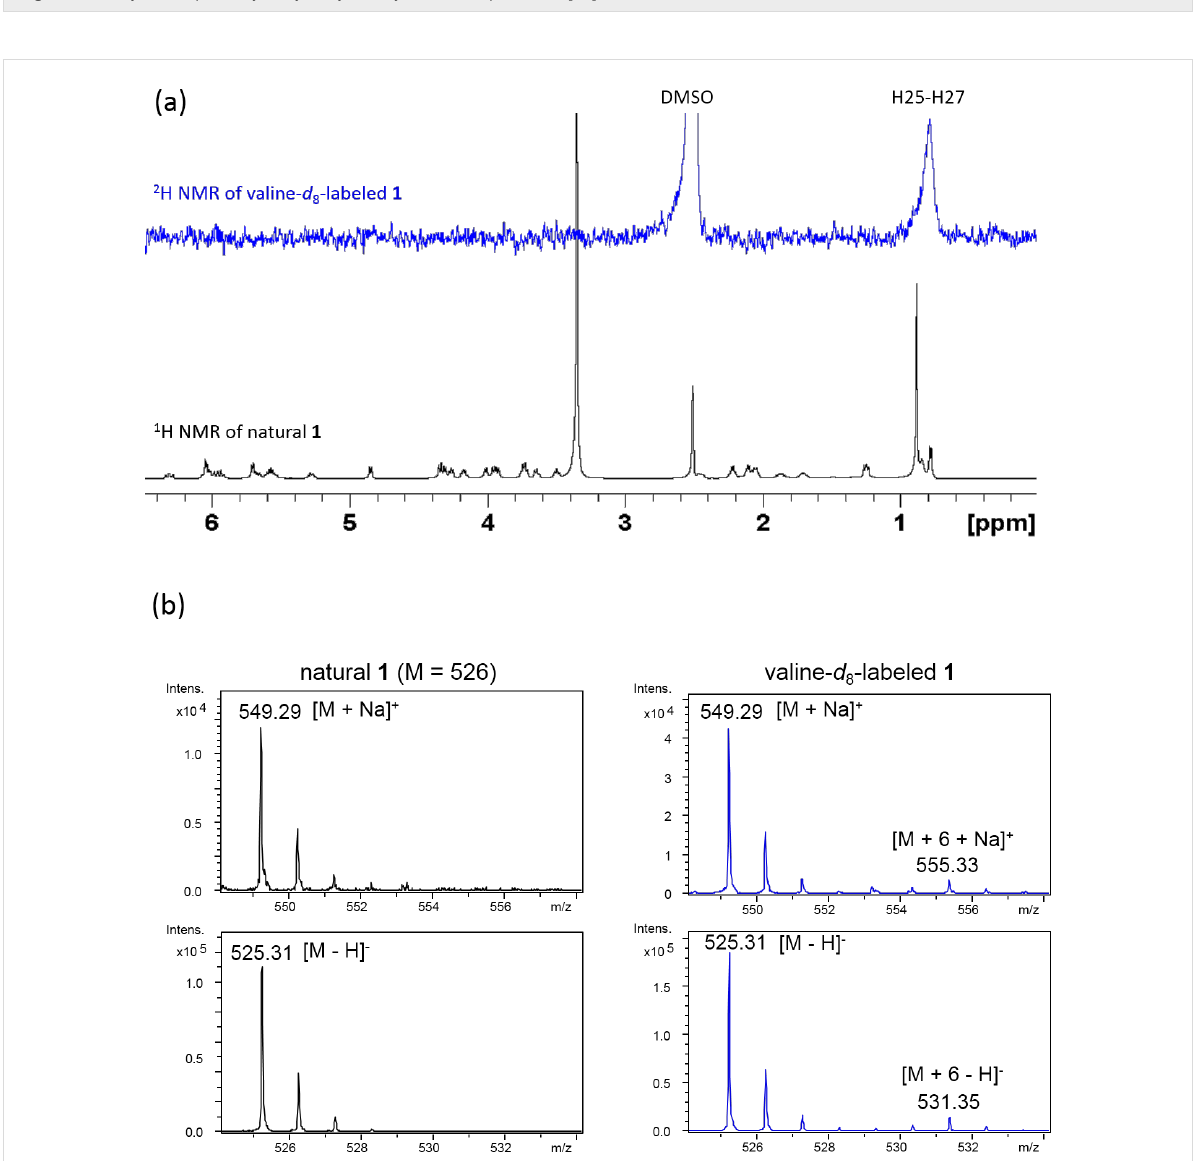
Figure 7: Incorporation of L-valine- d 8 into 1 . (a) 1 H NMR spectrum of natural 1 and 2 H NMR spectrum of L-valine- d 8 -labeled 1 . (b) ESIMS spectra of natural 1 and L-valine- d 8 -labeled 1